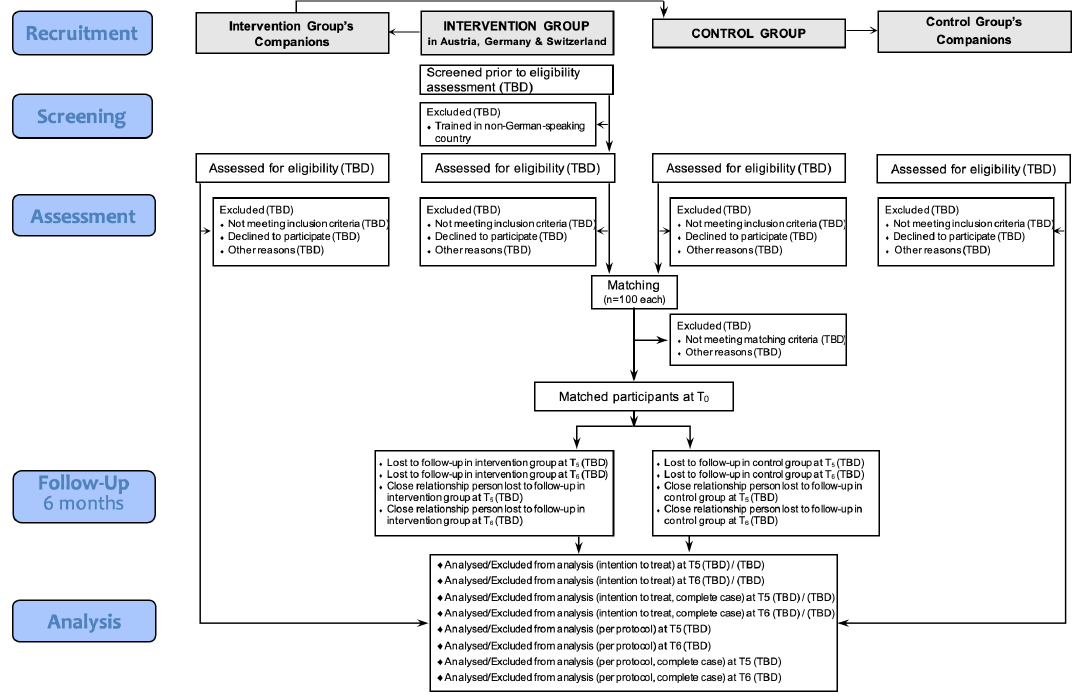
Figure 5. CONSORT 2010 Flow Diagram (Clinical Trial Registration Number: NCT04165473).